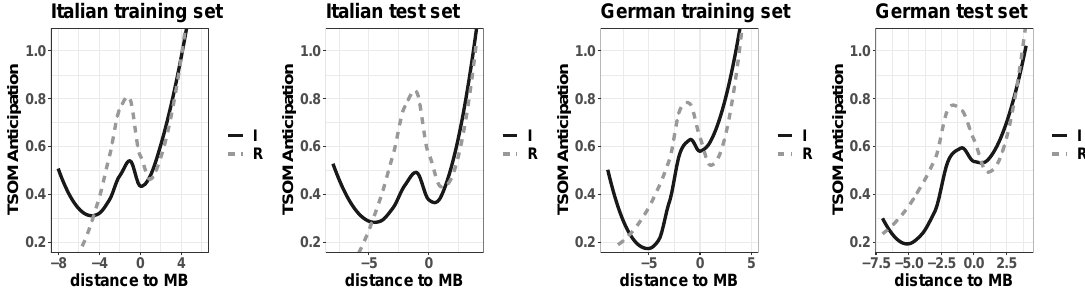
Figure 4. Regression plots of interaction between morphological (ir)regularity (Regulars versus Irregulars) and distance to morpheme boundary (MB) in non-linear models (GAMs) fitting the number of correctly anticipated symbols by the trained TSOMs on Italian ( left plots ) and German ( right plots ) for training and test